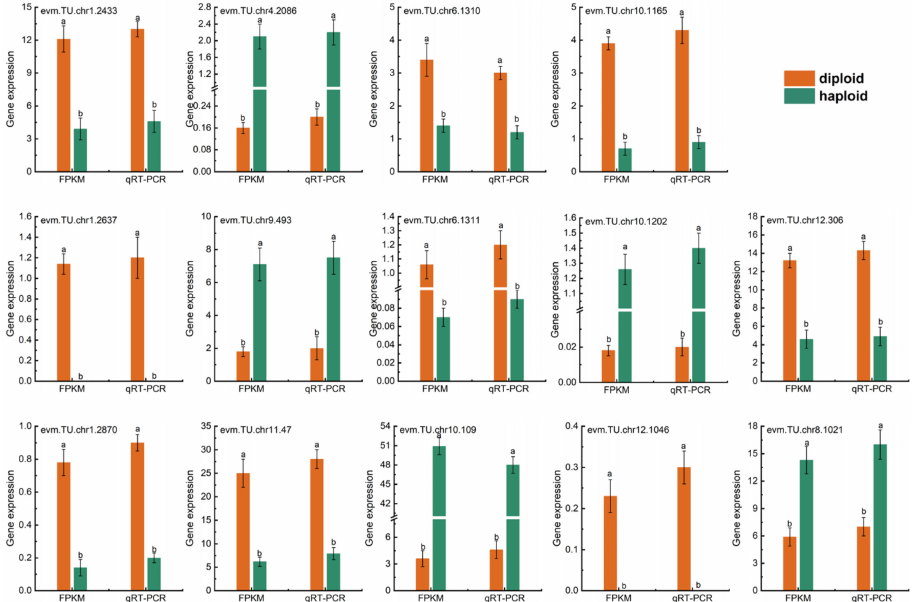
Figure 12. Validation of 14 chosen genes by qRT-PCR in haploid and diploid ginkgo leaves. Bars with different letters indicate significant differences at p < 0.05 according to Duncan’s